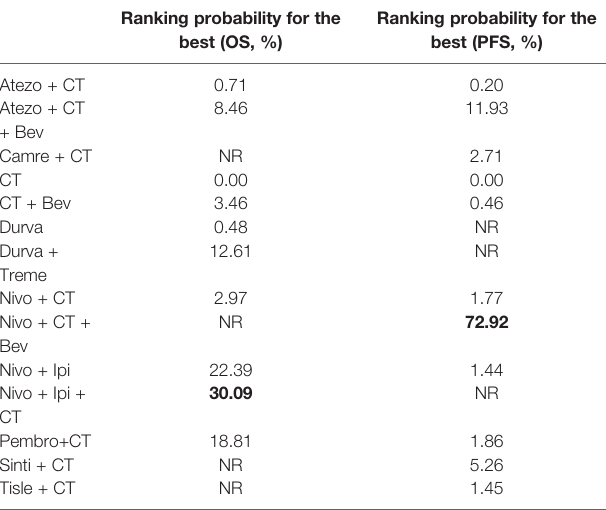
OS, overall survival; PFS, progression-free survival; CT, chemotherapy; Atezo, atezolizumab; Bev, bevacizumab; Nivo, nivolumab; Ipi, ipilimumab; Pembro, pembrolizumab; Carem, caremlizumab; Durva, durvalumab; Treme, tremelimumab; Tisle, tislezumab; Sinti, sintilimab; NR, not reported. Bold means the the highest ranking